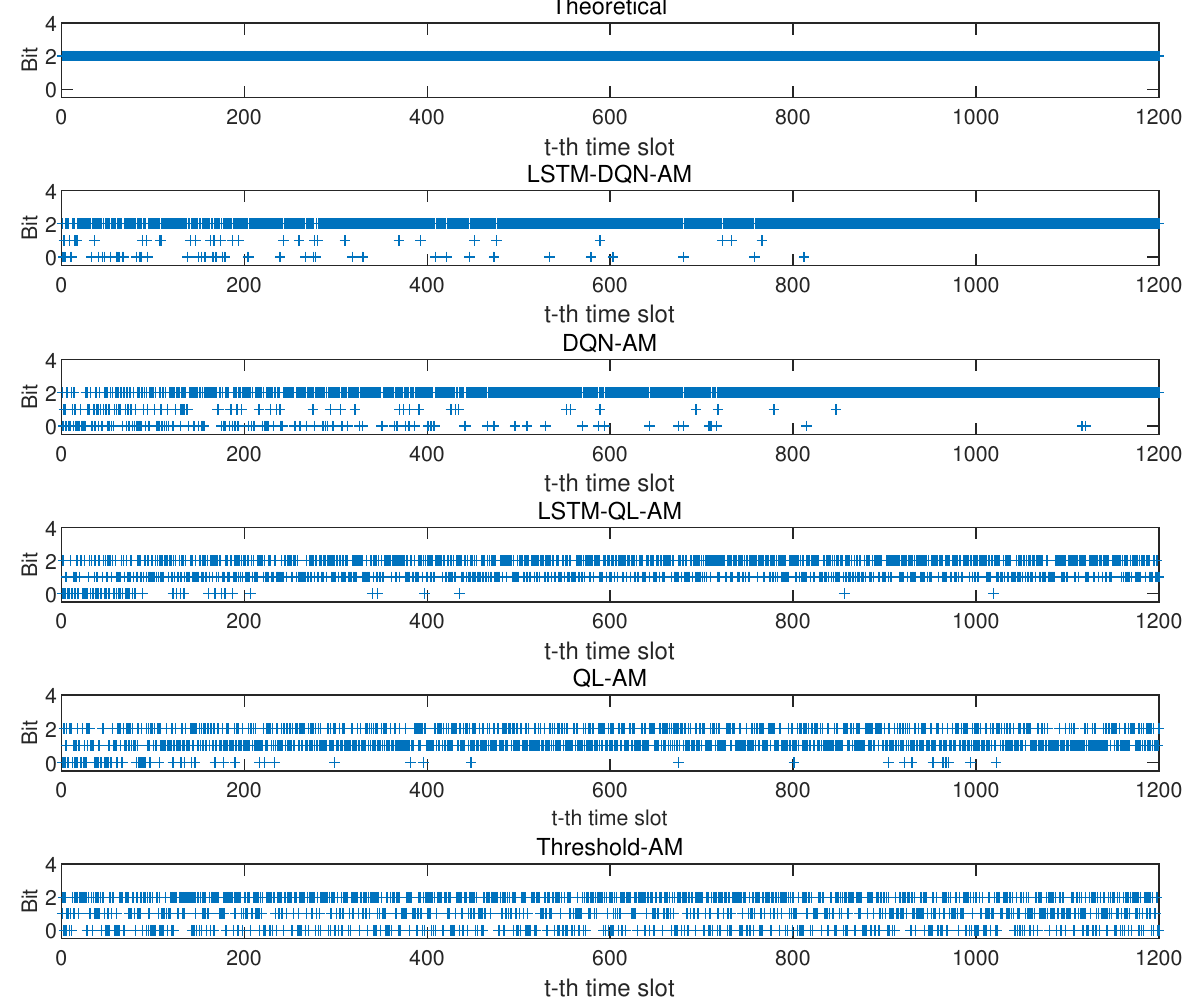
Figure 11. The received number of bits in the AM schemes in the pool experiments. During the AM mode selection, when the channel conditions were poor, the AM systems selected a low-order modulation method with lower bit rates to maintain reliable communication. On the contrary, in good channel conditions, the systems selected high- order modulation with higher bit rates to improve the system throughput. As shown in Figure 11, the theoretical scheme had no transmission failures and selected the modulation mode with a high bit rate, according to the ideal CSI while guaranteeing the BER. In the early stages, LSTM-DQN-AM converged faster than the other schemes, which corresponded to fewer failures and the more frequent selection of higher-order modulation modes under the BER constraints. After convergence, our proposed LSTM-DQN-AM had no transmission failures. This indicated that LSTM-DQN-AM could better match the time-varying channel states in the pool experiments using adaptive